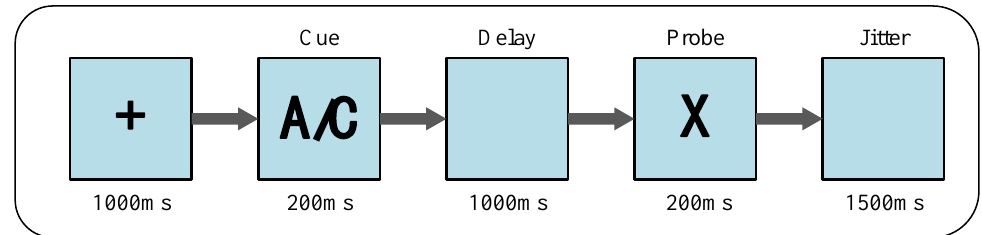
Figure 3. Task parameters and timing for the